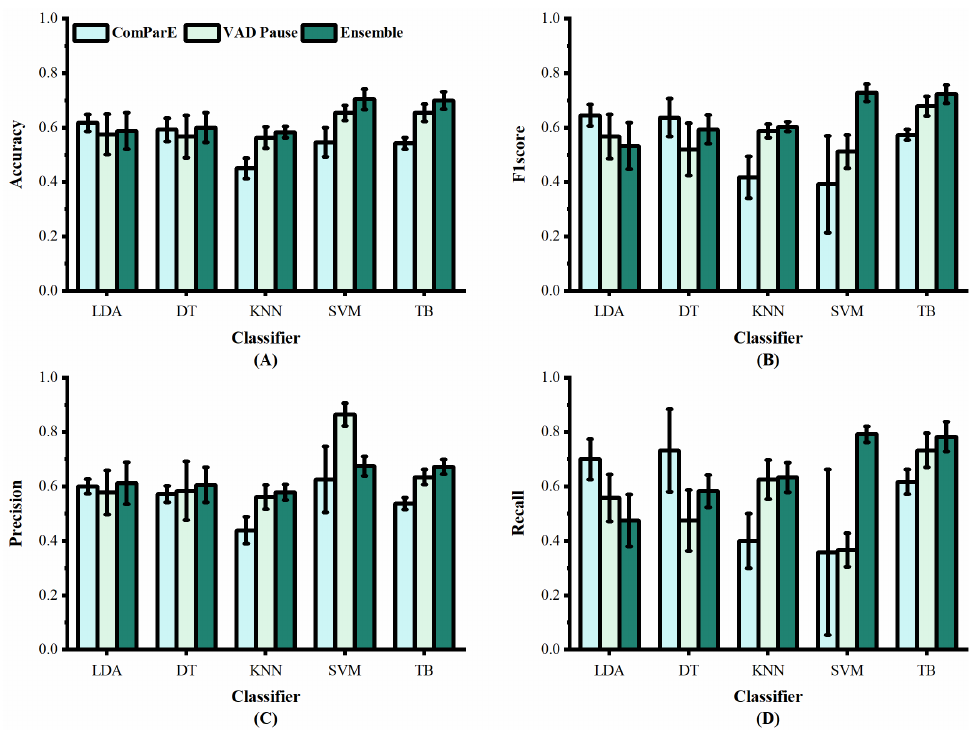
Figure 5. Performance of features from our study and [29] on dataset ADReSS: ( A ) accuracy; ( B ) F1 score; ( C ) precision; ( D ) recall.